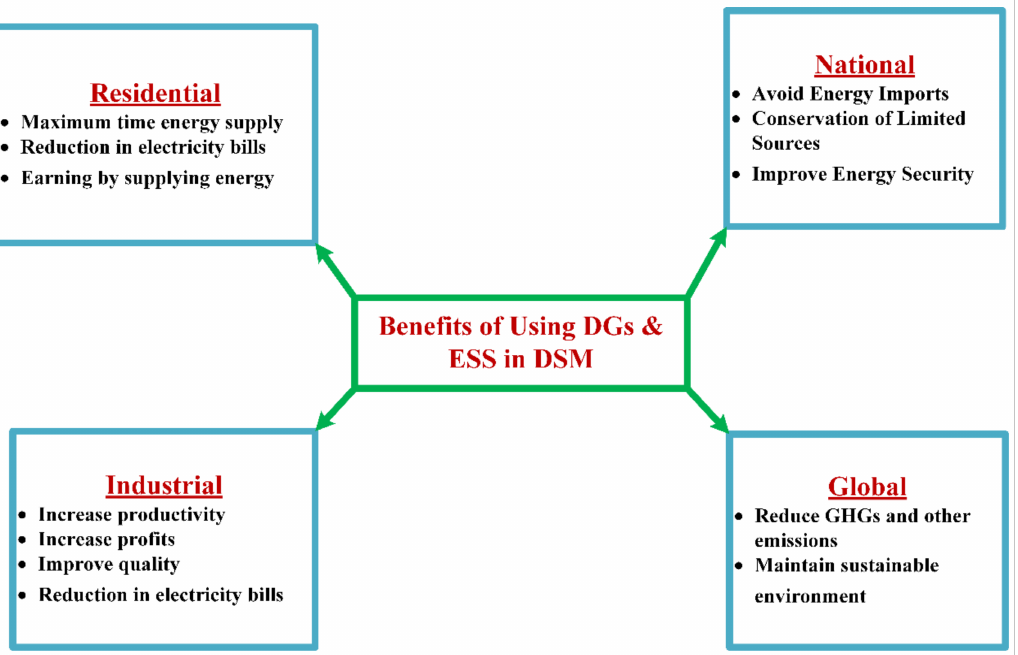
Figure 7. Benefits of using DGs and ESS in DSM.